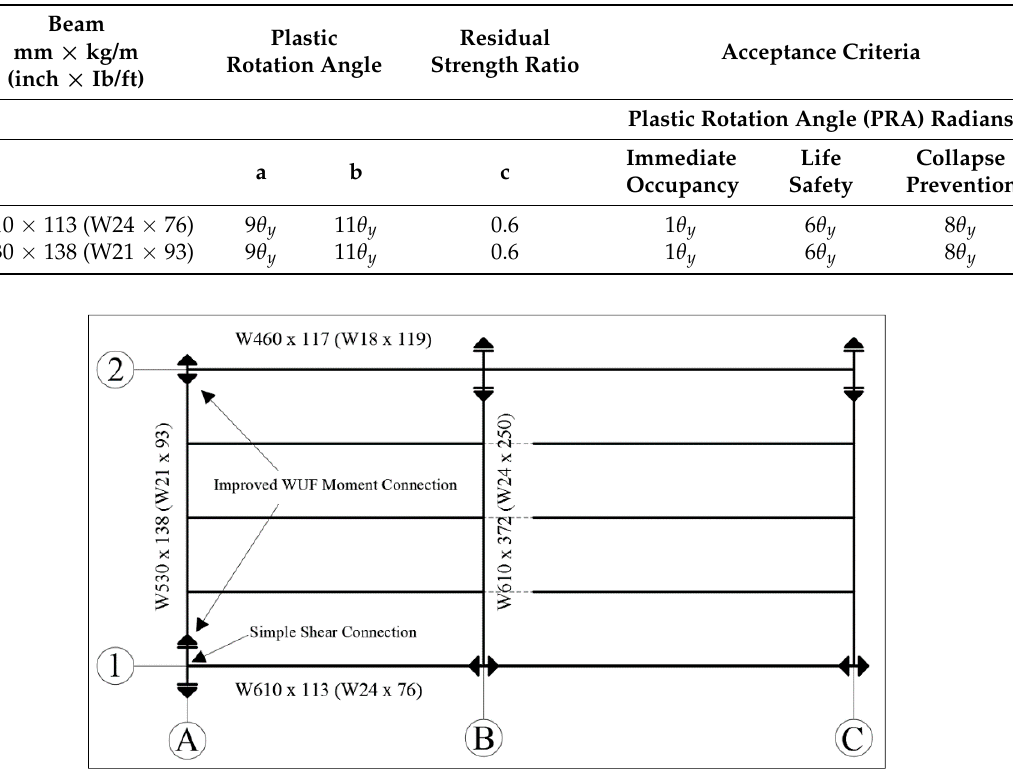
Figure 7. Partial plan view at the location where corner column A1 will be notionally removed at the base level.